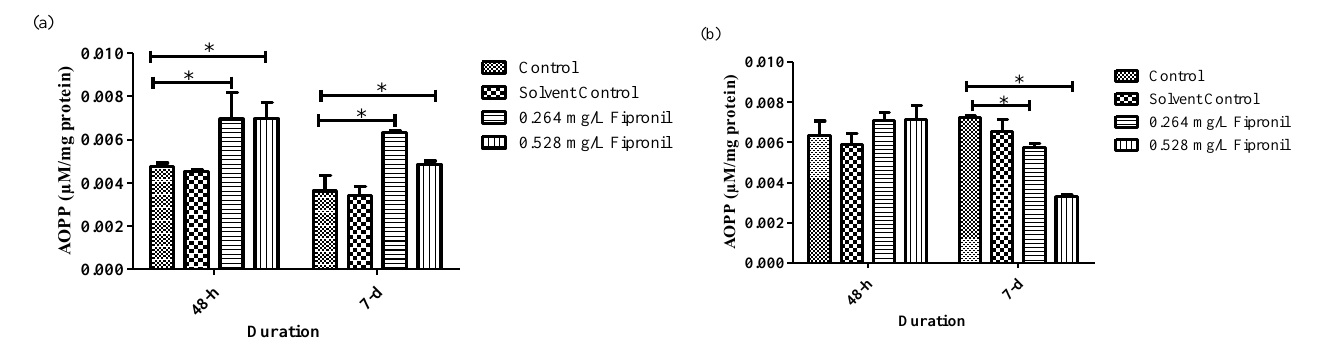
Figure 4. The AOPP levels (mean ± SEM) of ( a ) the digestive gland and ( b ) the gill tissues of freshwater mussels. * indicates p < 0.05.